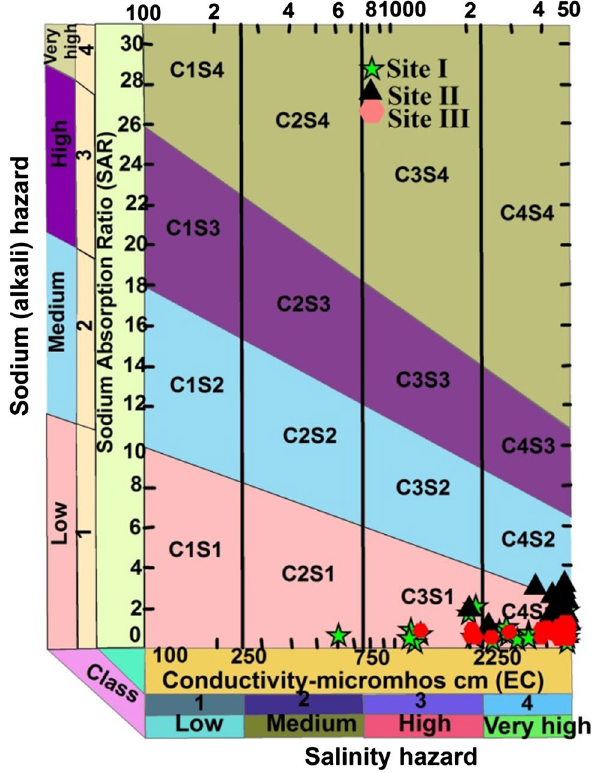
Fig. 5 USSL classification in the study area